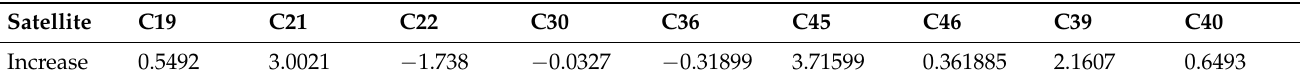
Table 5. Relative increase in PLL discriminator output accuracy for B2a and B2b